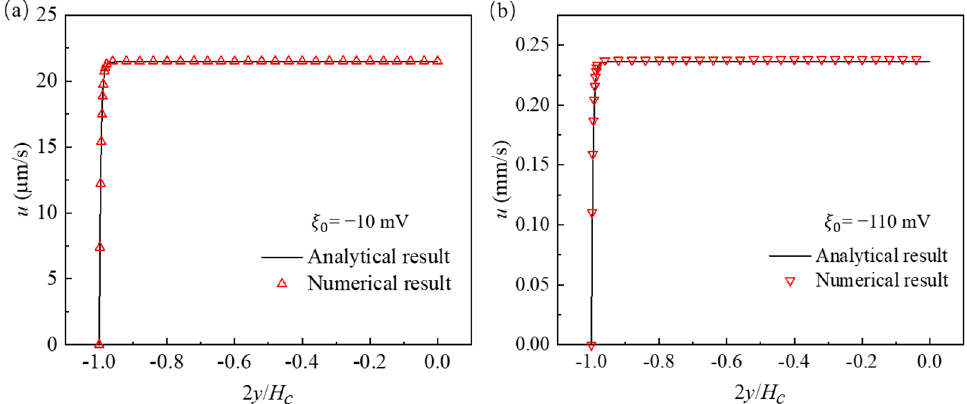
Figure 4. ( a ) Electric potential distribution (blue dash line shows the relative position of the geom- Figure 5. The x -component velocity profile of viscoelastic electroosmotic flow (EOF) between two etry) along the x -axis; ( b ) the x -component velocity at the center of the constriction microchannel, parallel plates: ( a ) Zeta potential is − 10 mV; ( b ) zeta potential is − 110 mV. Analytical result of 𝑢(0,𝑦) , for Newtonian model (solid line) and OB model (symbol).